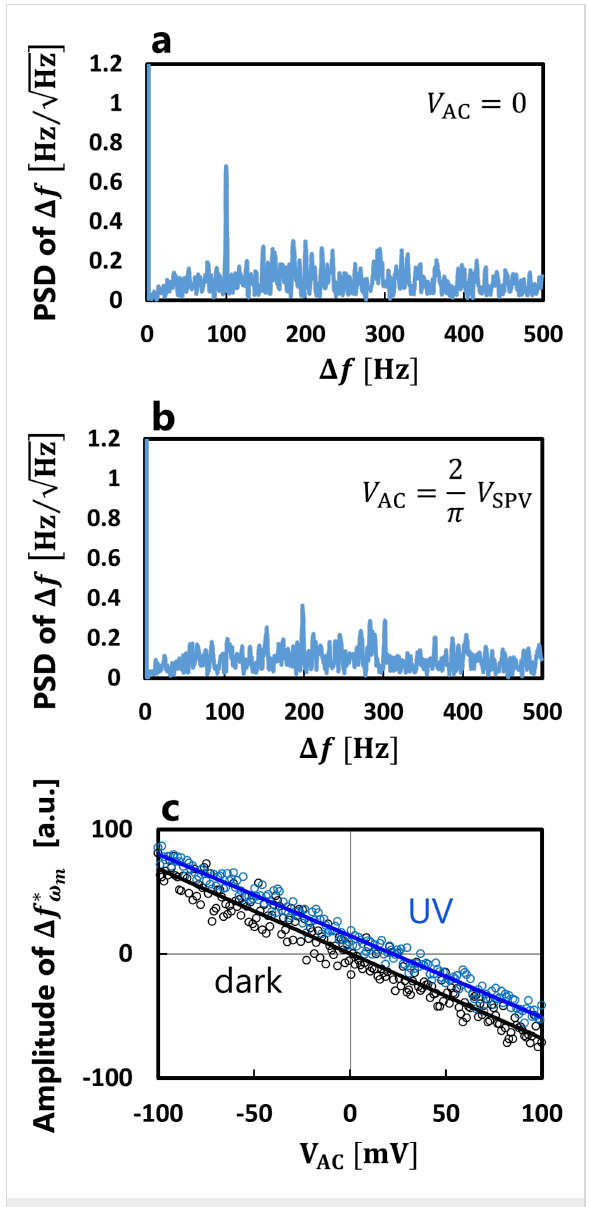
Figure 2: PSD of Δ f under modulated UV laser illumination ( f m = 100 Hz) with (a) V AC = 0 and (b) V AC = 2/ π V SPV , where V AC nullifies the SPV. (c) Dependence of the amplitude of (the peak at 100 Hz in (a)) on V AC in darkness (black) and under UV illumination (blue) measured using a lock-in amplifier. Circles and solid lines are experimental data and fit results,